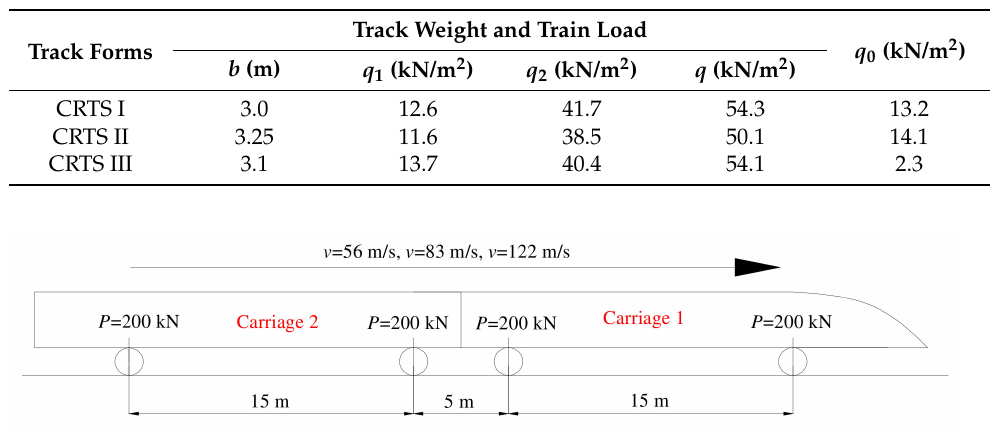
Figure 4. Simplified train loads in the numerical